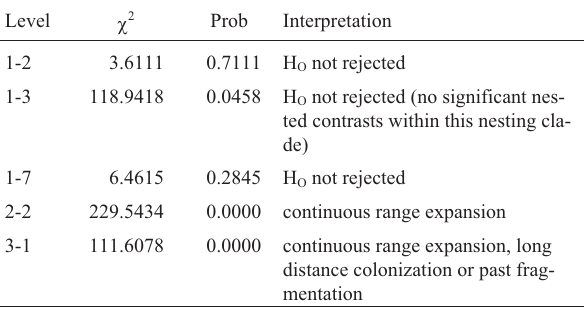
Table 3 - Results of Nested Clade Analysis (NCA) of C. crocodilus . Level refers to the nesting clades shown in Figure 2. Only those nesting clades that show genetic or geographic variation are reported. Permutational χ 2 probability is assessed by randomly permuting the lower level